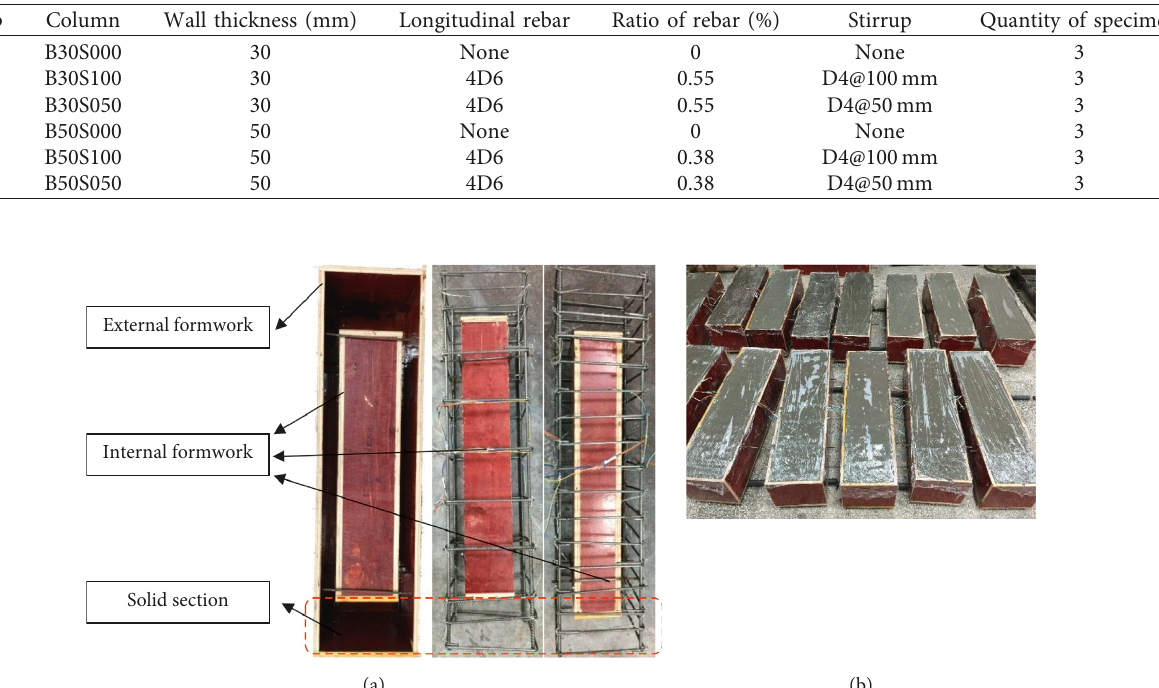
Table 3: Parameters of the tested column specimens.